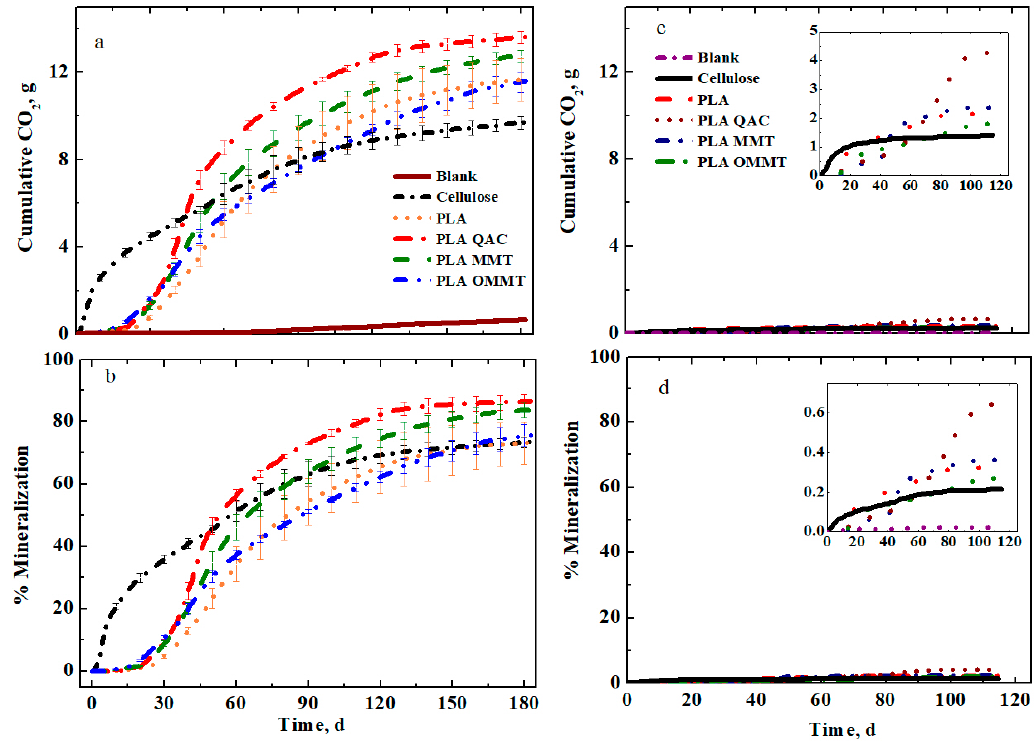
Figure 1. CO 2 evolution ( a ) and % Mineralization ( b ) of PLA, PLA QAC, PLA MMT and PLA OMMT films in inoculated vermiculite and CO 2 evolution ( c ) and % Mineralization ( d ) for non-inoculated